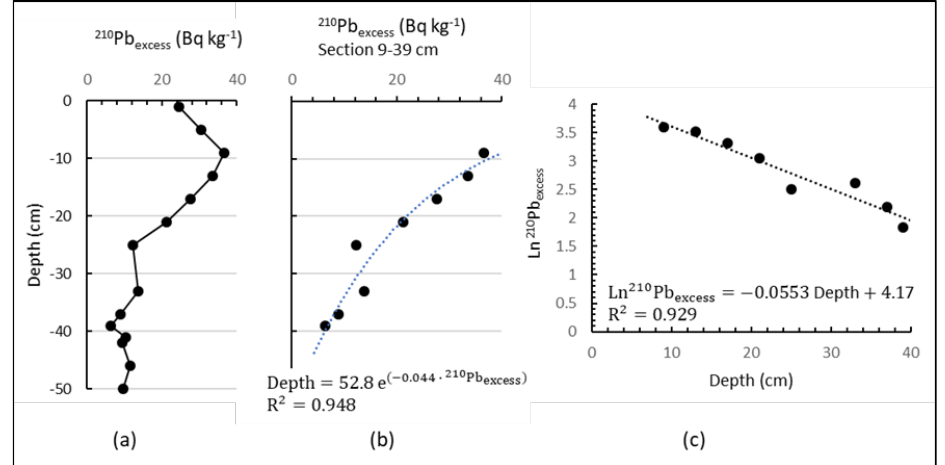
Figure 8. ( a ) 210 Pb excess profile in the entire core, ( b ) 210 Pb excess plotted against the core depth in the